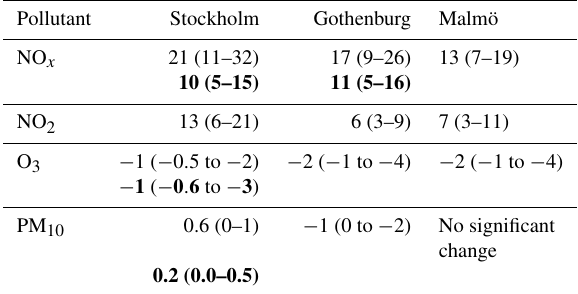
Table 1. Change in life expectancy in months with 95% CI in brackets, caused by a change in exposure during the measured pe- riods. Decreasing trends are associated with an increase in life ex- pectancy, and increasing trends are associated with a decrease in life expectancy (minus signs). The changes in life expectancy, adjusted for population-weighted exposure concentrations (see Sect. 2.5 and Figs. A1–A4), are presented in bold below the ordinary values. Note